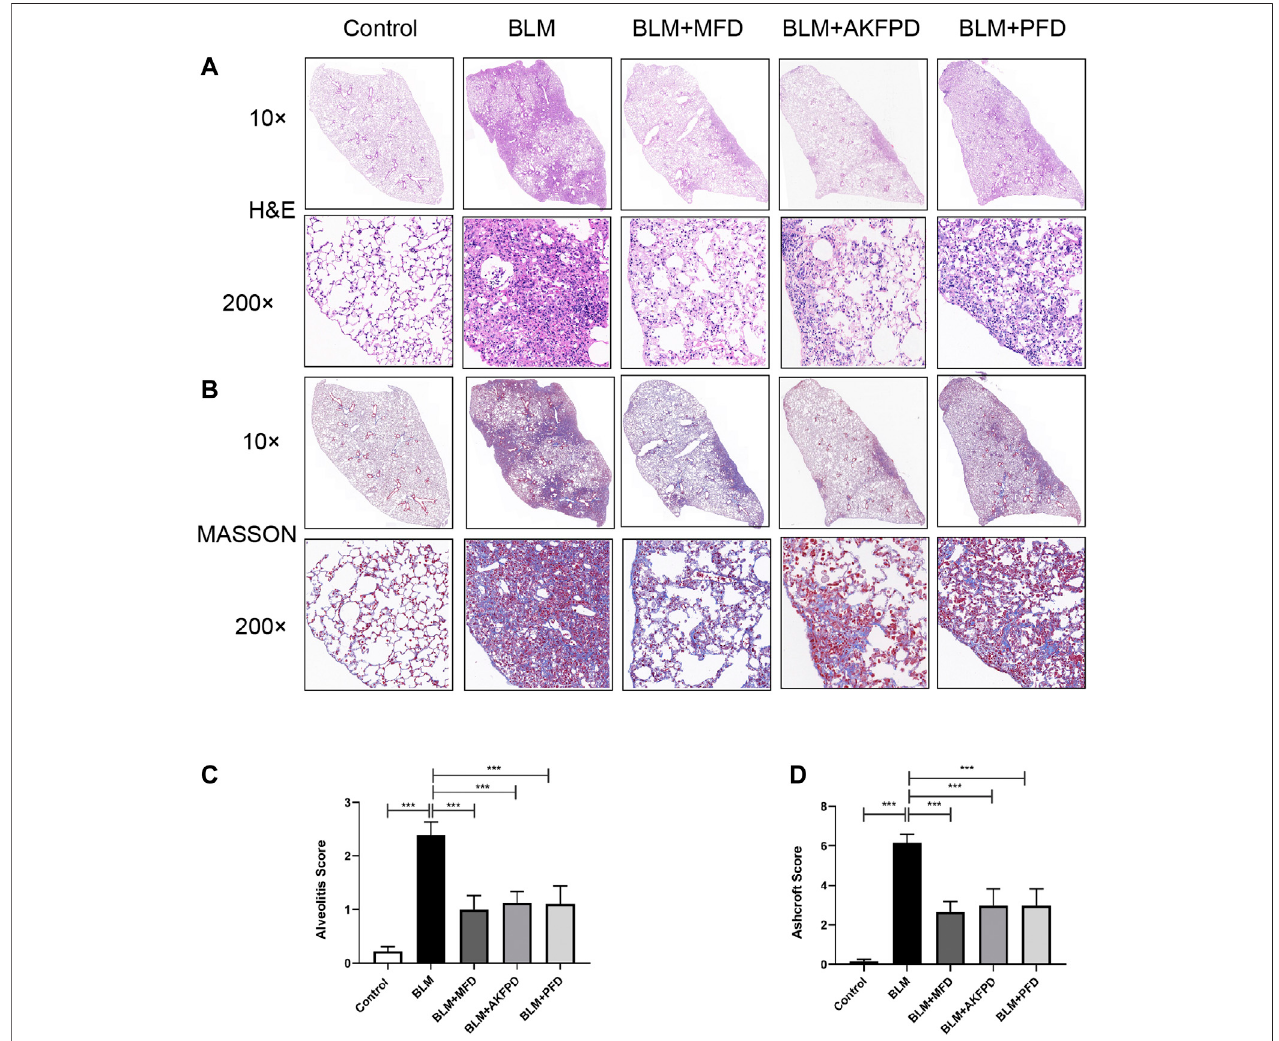
FIGURE 1 | Mefunidone ameliorated bleomycin-induced pulmonary fi brosis. Pulmonary fi brosis was induced by bleomycin (10 mg/kg, iv) and the lungs were collected28 daysafterbleomycininjection.MiceinBLM+MFD,BLM+AKFPDandBLM+PFDgroupsweretreatedwithmefunidone, fl uorofenidoneorpirfenidonerespectively by gavage for 28 days (A – B) : Representative images of H and E staining (A) and Masson ’ s trichrome staining (B) of lung tissues from different groups of mice (C-D) : Alveolitis scoring (C) and Ashcroft scoring (D) of different groups. All data were presented as mean ± SD. ANOVA was used for comparison in (C-D) . *** p < 0.001.